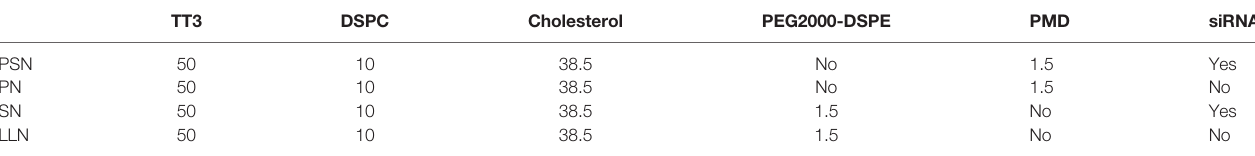
TABLE 1 | The molar ratio of each component in the synthesis of liposomal nanoparticles. TT3